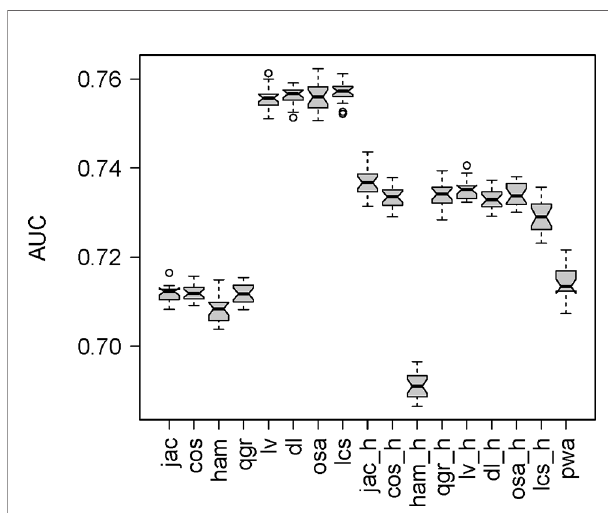
FIGURE 3 | Box plot of the area under the ROC curve for the detection of isospeci fi c pairs of mimotopes using diverse string metrics. Ham - Hamming distance, lcs - longest common subsequence distance, lv - Levenshtein distance, dl - Damerau-Levenshtein distance, osa - optimal string alignment, qgr - q-gram distance, cos - cosine distance between q-gram pro fi les, jac - Jaccard distance between q-gram pro fi les, pwa - pair-wise alignment (BLOSUM62 substitution matrix based), … _h - versions of string distances with recoded amino acids (AA) based on the Phys\Chem properties. The recoding of the AA aimed at assigning the same letter to AA of the same property but when one AA was grouped in more than one property set the letter was chosen at the point of comparison to match (if possible) the property set of the counterpart AA. This approach was meant to make possible the use of string distance metrics in the context of physicochemical properties